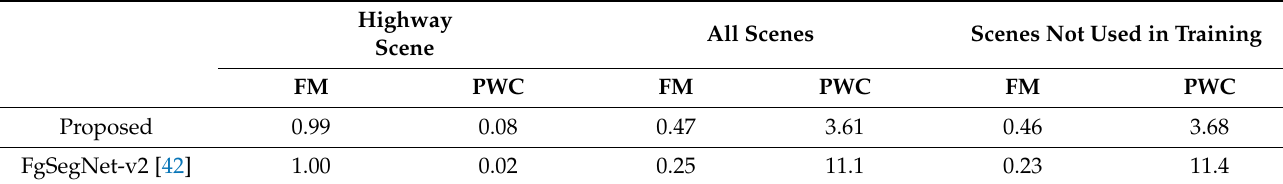
Table 2. Comparison of results obtained by training using one scene (Highway) in the CDnet 2014 dataset.